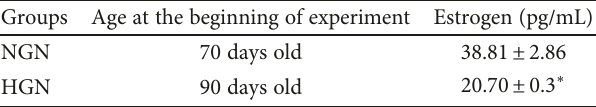
Table 1: Characteristics of the animals at the beginning of the study. Groups Age at the beginning of experiment Estrogen